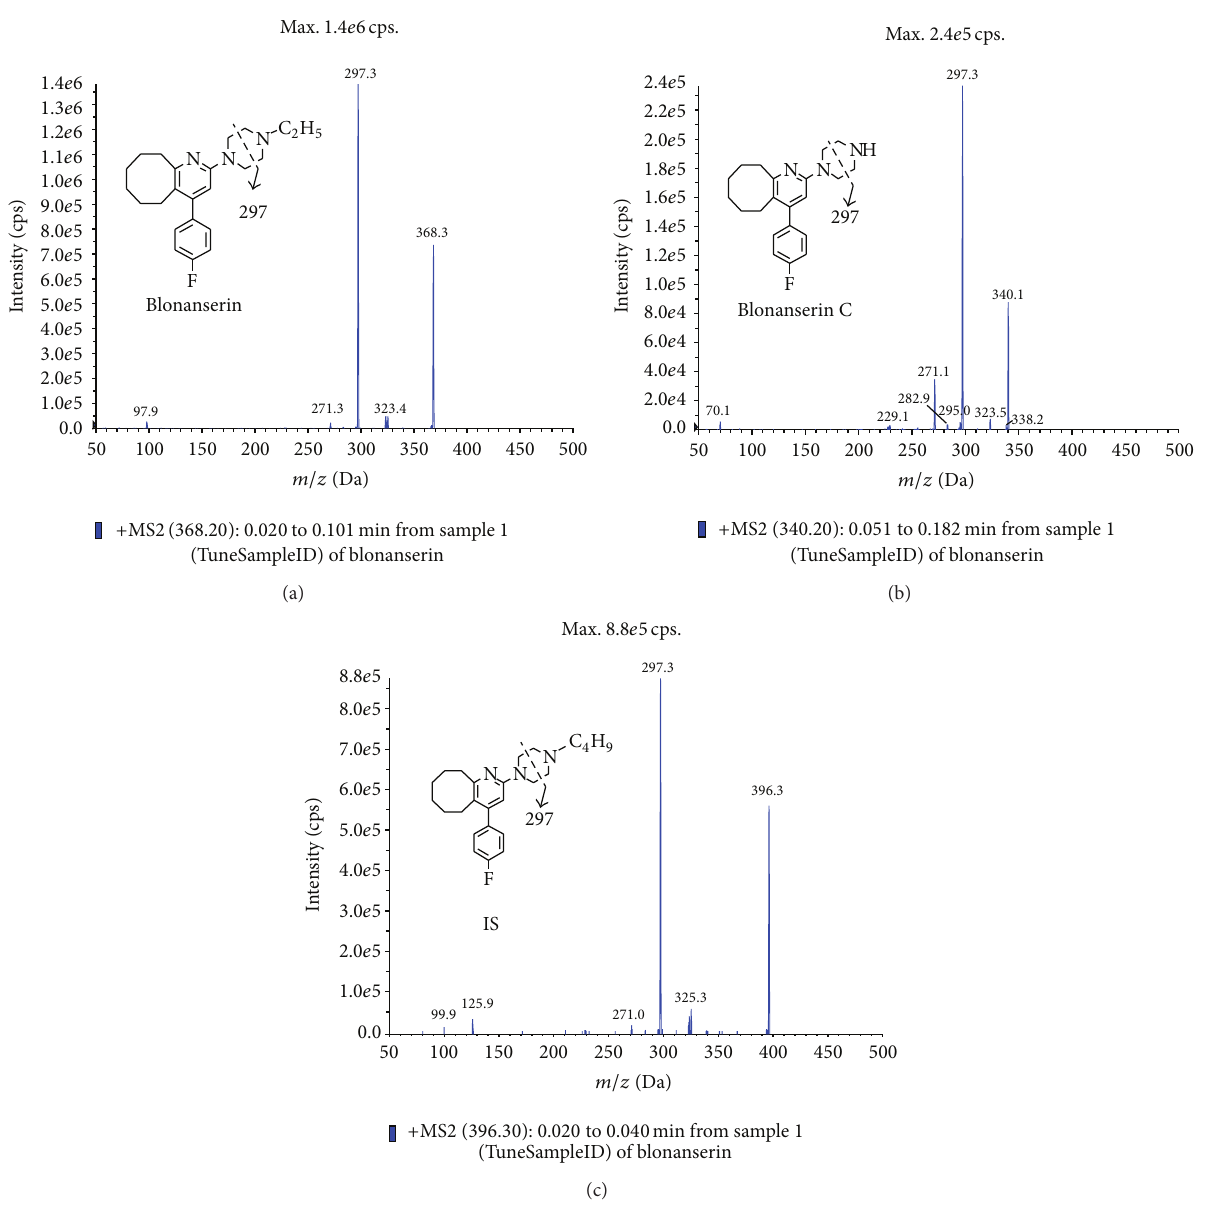
Figure 1: The structures and MS 2 spectrums of blonanserin (a), blonanserin C (b), and IS (c).